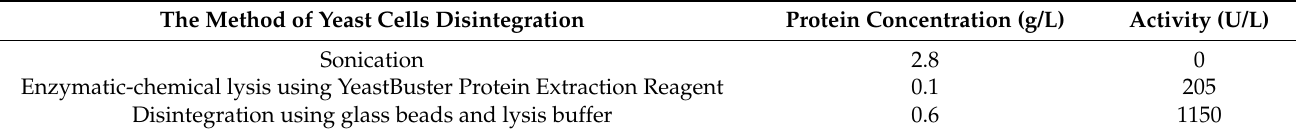
Table 5. The activity of Paracoccus sp. 32d β - D -galactosidase and protein concentration in cell-free